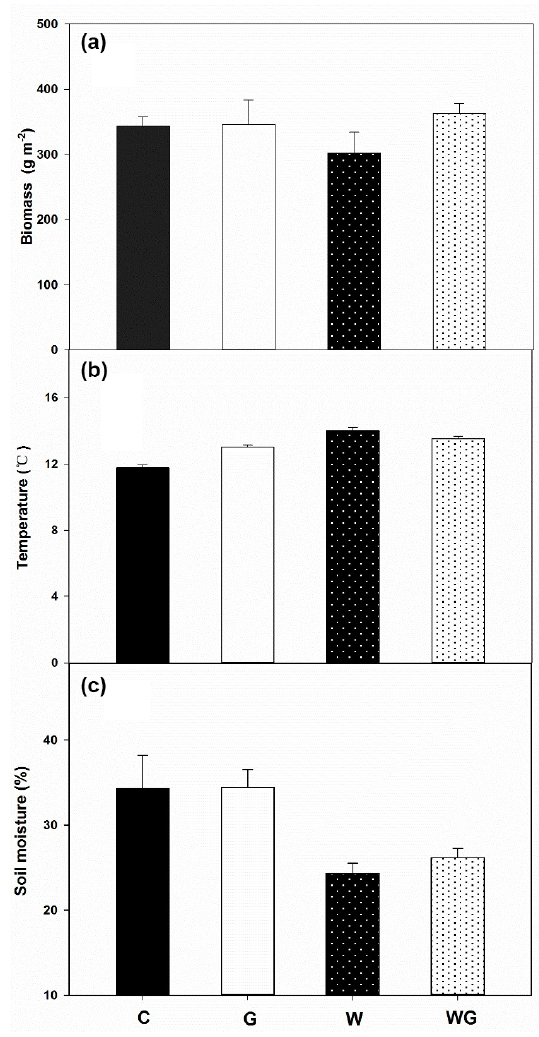
Figure 1. Plant biomass (a) soil temperature (b) and soil moisture content (c) in an alpine meadow. C (black bar), control treatment; G (white bar), winter grazing treatment; W (white-dotted bar), warm- ing treatment; WG (black-dotted bar), warming combined with the winter grazing treatment. Values are means ± 1s.e.m. ( n =